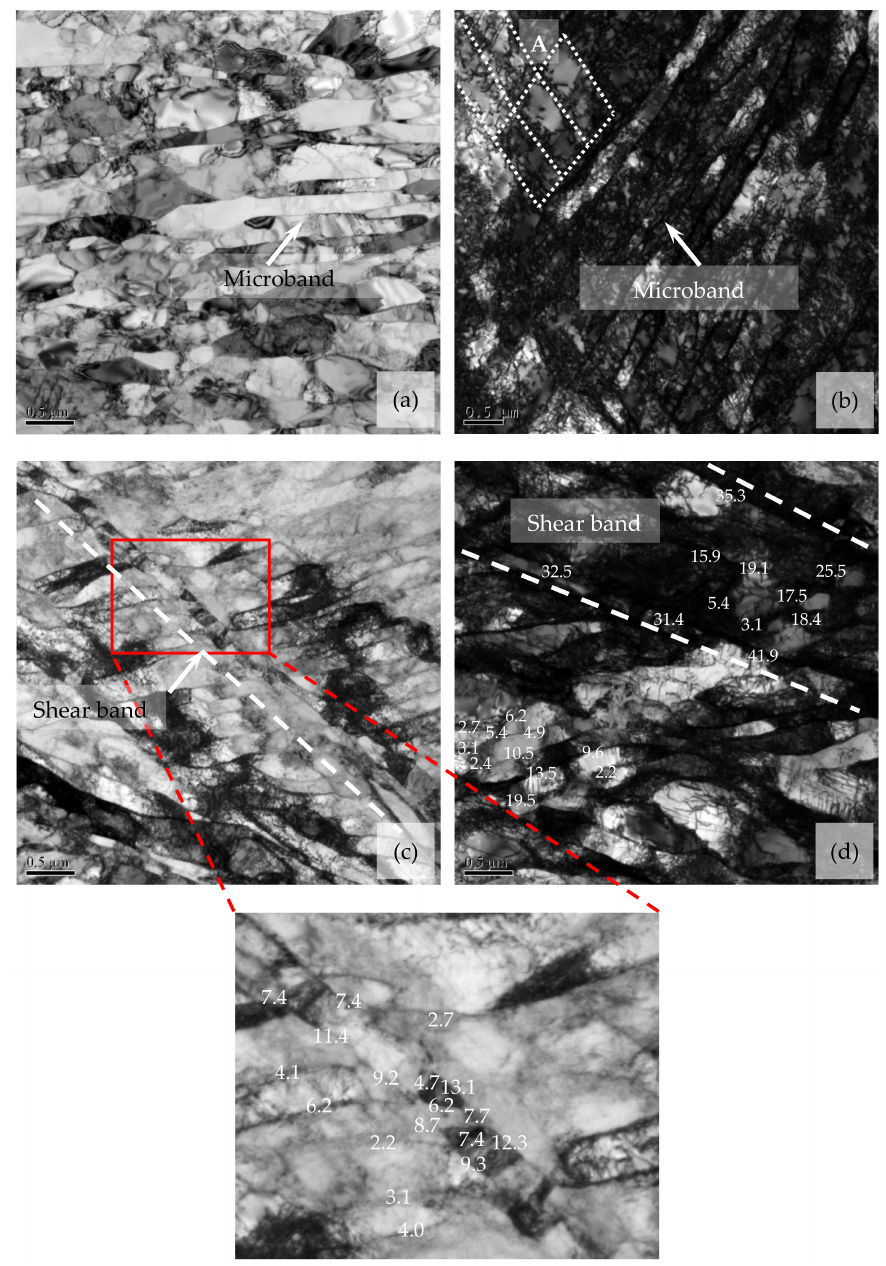
Figure 13. TEM analyses of the dynamic microstructures after deformation at Z = 3.34 × 10 30 and strain of 0.55 (The insert in Figure 13c shows the misorientation analyses of some strain-induced subgrain boundaries at and near the shear band. The numbers indicate the misorientation angles between subgrains obtained by using precession electron diffraction ( ◦